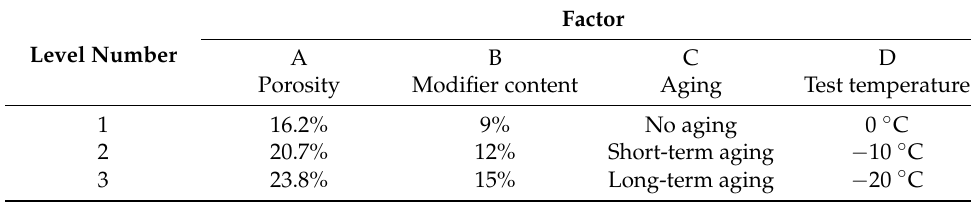
Table 12. Values of levels of each